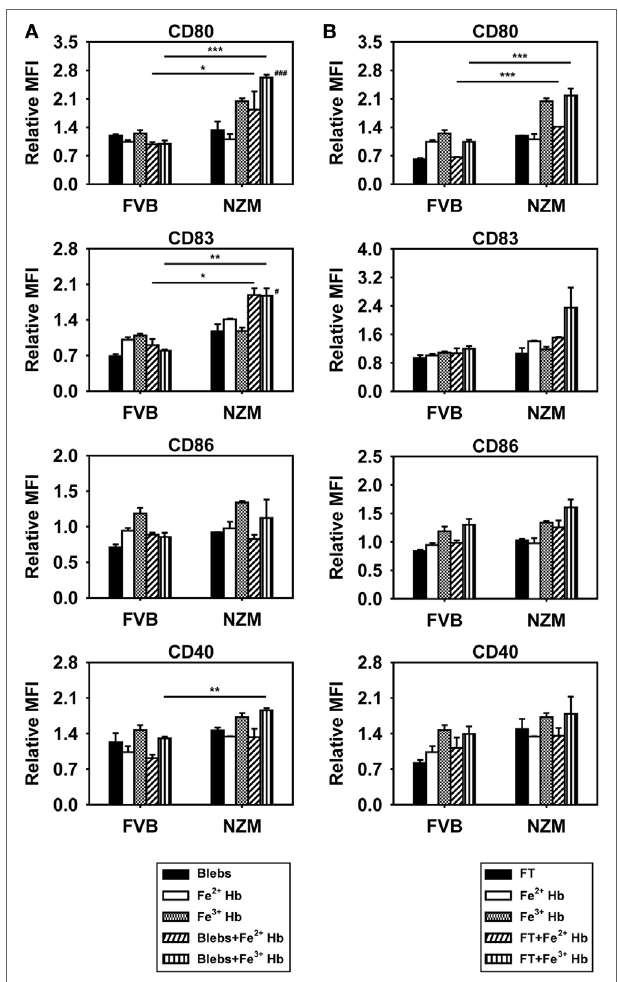
FigUre 5 | Effects of hemoglobin (Hb) and apoptotic blebs/freeze–thawed cellular lysate (FT) on maturation of bone marrow-derived dendritic cells (BMDCs) derived from 2-month-old FVB or NZM mice. Flow cytometric analysis of the expression of CD80, CD83, CD86, and CD40 on CD11c + BMDCs stimulated with 0.5 mM Hb (Fe 2 + or Fe 3 + ) along with (a) apoptotic blebs (1 µg/ml) or (B) FT (1 µg/ml). Relative MFI: ratio of mean fluorescence intensity of stimulated over un-stimulated BMDCs. Data represent mean ± SEM. Differences individually attributable to Hb or blebs are not indicated. # p < 0.05, ### p < 0.001 vs Fe 3 + Hb and vs apoptotic blebs in the same strain; * p < 0.05, ** p < 0.005, *** p < 0.001. Data derived from three independent experiments, each carried out in triplicate ( n = 18; 9 NZM, 9